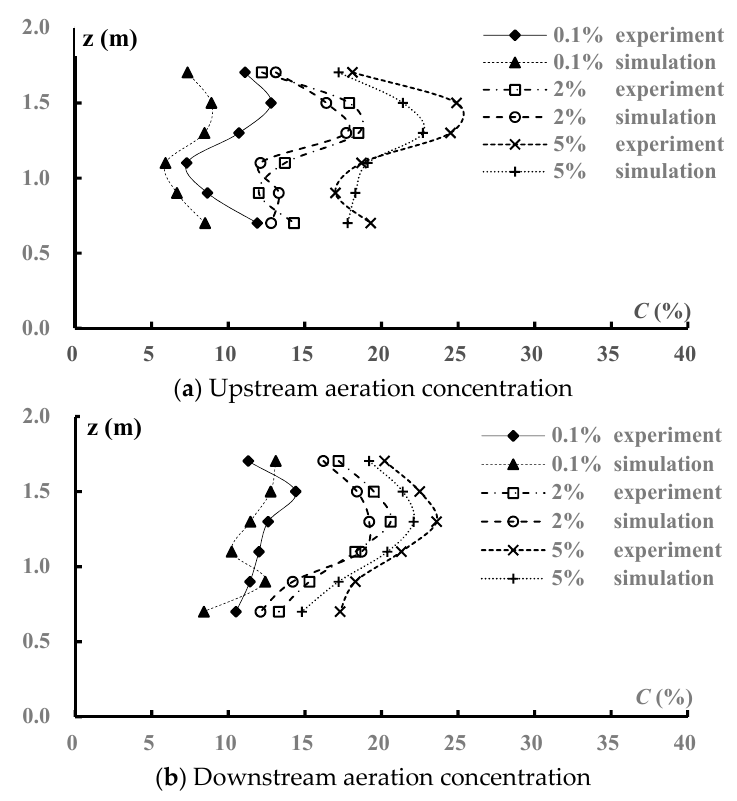
Figure 14. Aeration concentration in the vortex drop shaft.